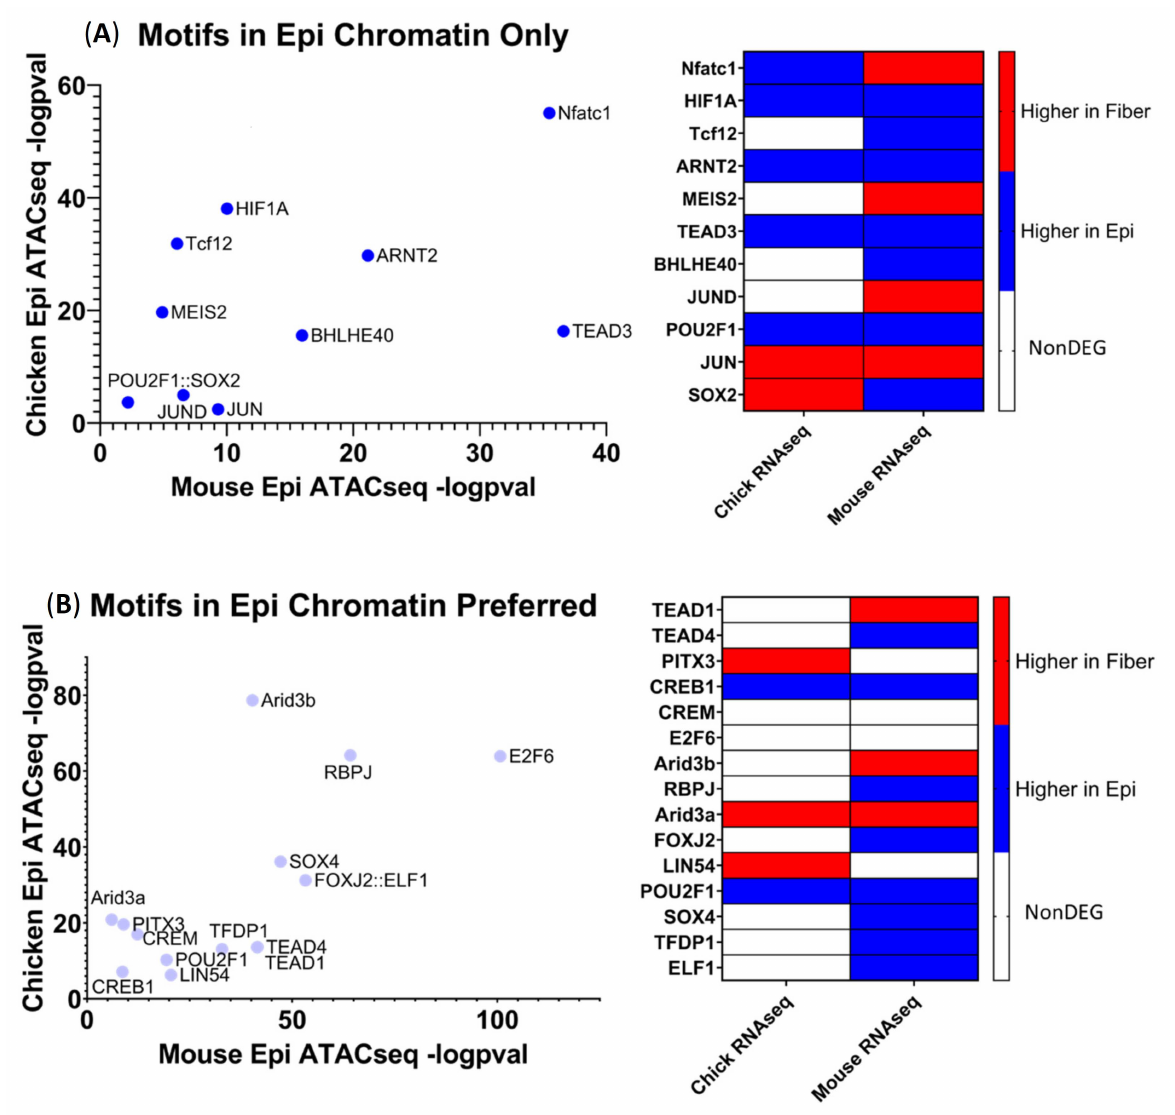
Figure 9. Transcription factor motifs enriched in open chromatin near evolutionarily conserved epithelial cell genes. ( A ) Transcription factor motifs enriched only in open chromatin near epithelial cell genes. ( B ) Transcription factor motifs more significantly enriched in open chromatin near epithelial cell genes as compared to fiber cell